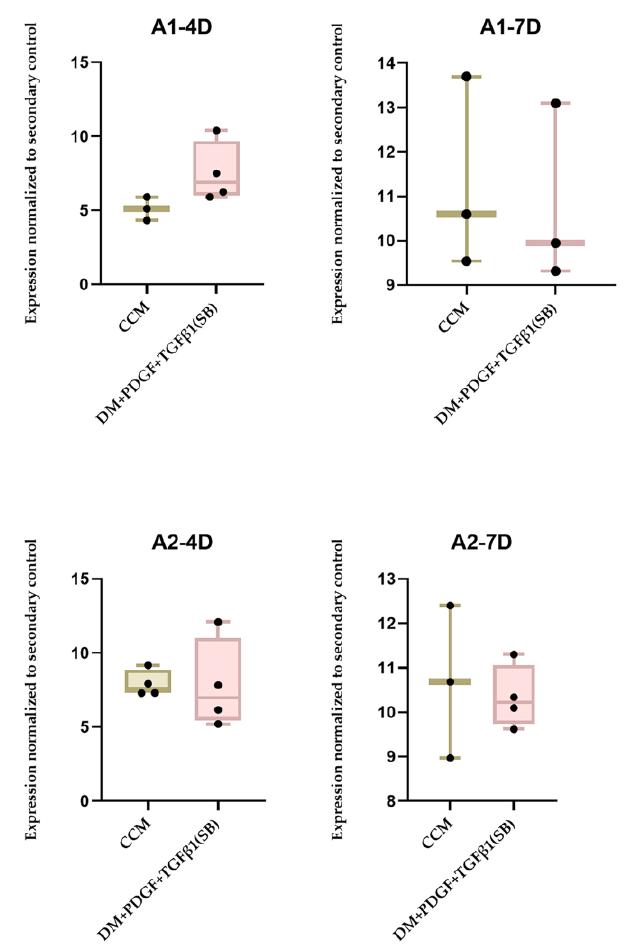
Figure 5. Comprehensive flow cytometry data from human adipose (AD)-MSC cell lines (A1,A2) subjected to PT supplemented DM semi-batch culture at four-(A1–4D,A2–4D) and seven-(A1–7D,A2–7D)day time points (n = 3 per cell-line/treatment/timepoint) and analysis of MYH II expression compared to cell lines cultured in CCM (control). The treatments without primary antibody addition are considered secondary controls. The differences between the treatments were not statistically significant. Each data point was obtained based on the measurement of 20,000 events in FACS CANTO